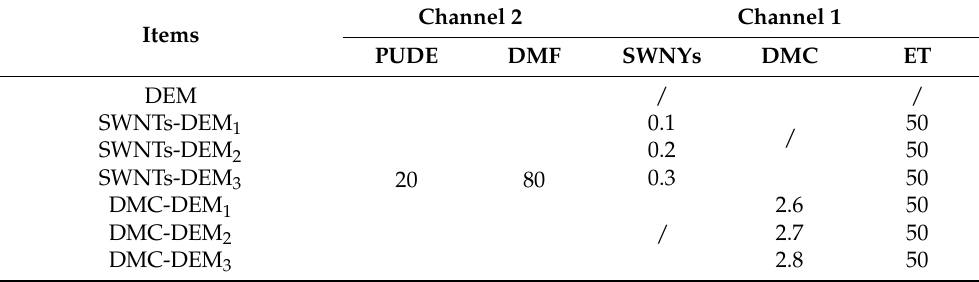
Table 3. Formulas of the polyurethane composite fiber membranes.